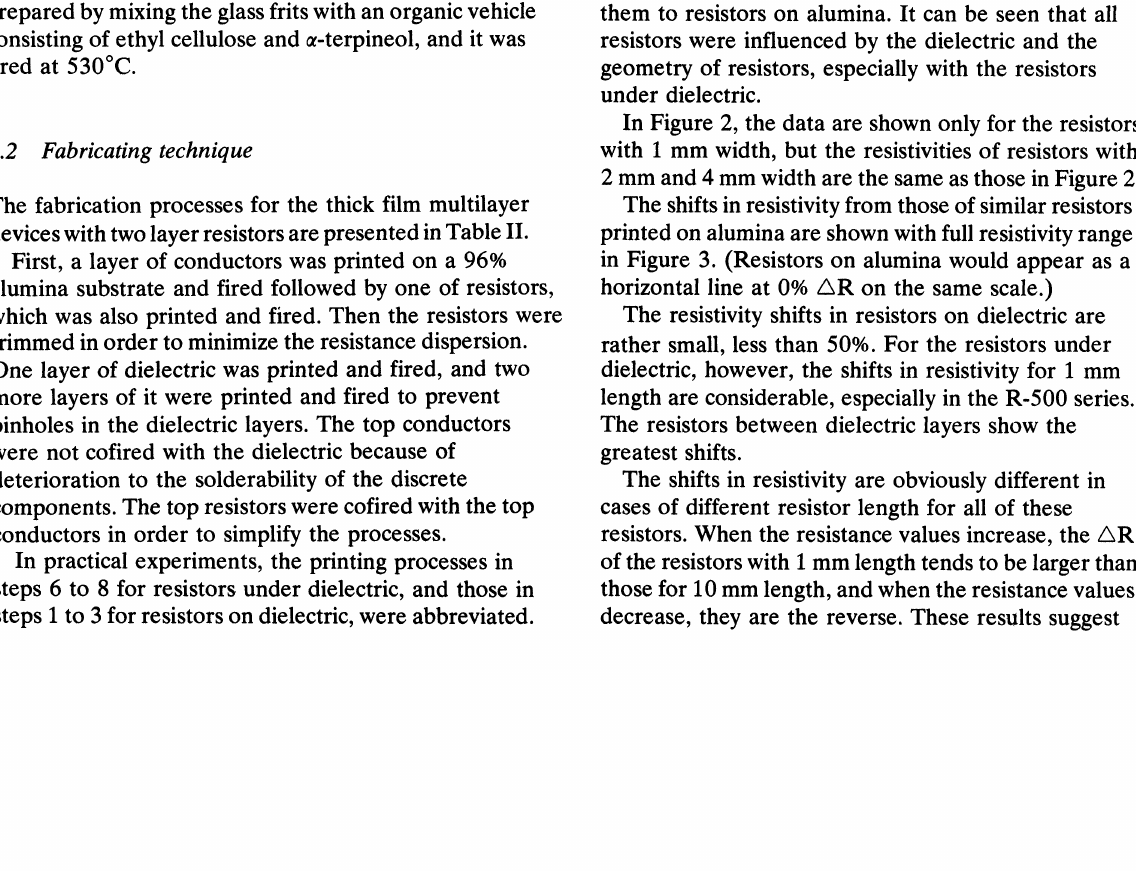
TABLE List of resistor